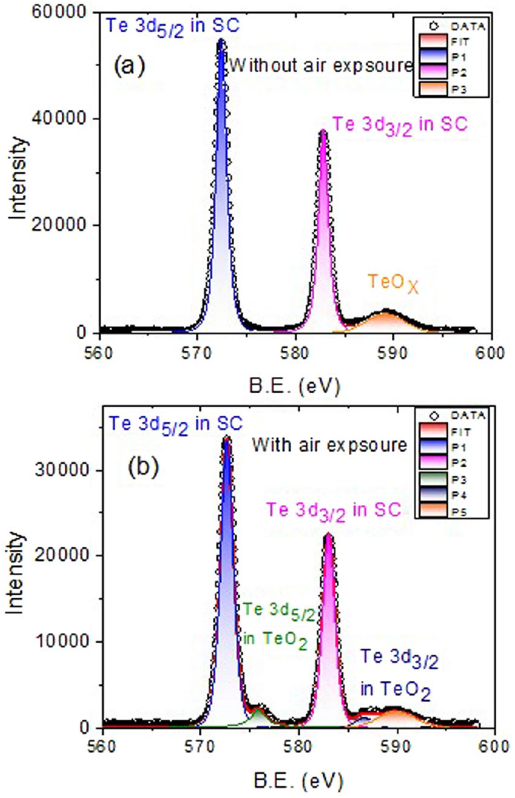
Figure 8. XPS results of the Te 3d scan, showing a small oxidation peak when the crystal was exposed to N 2 . The estimated oxidation layer thickness is 2.8